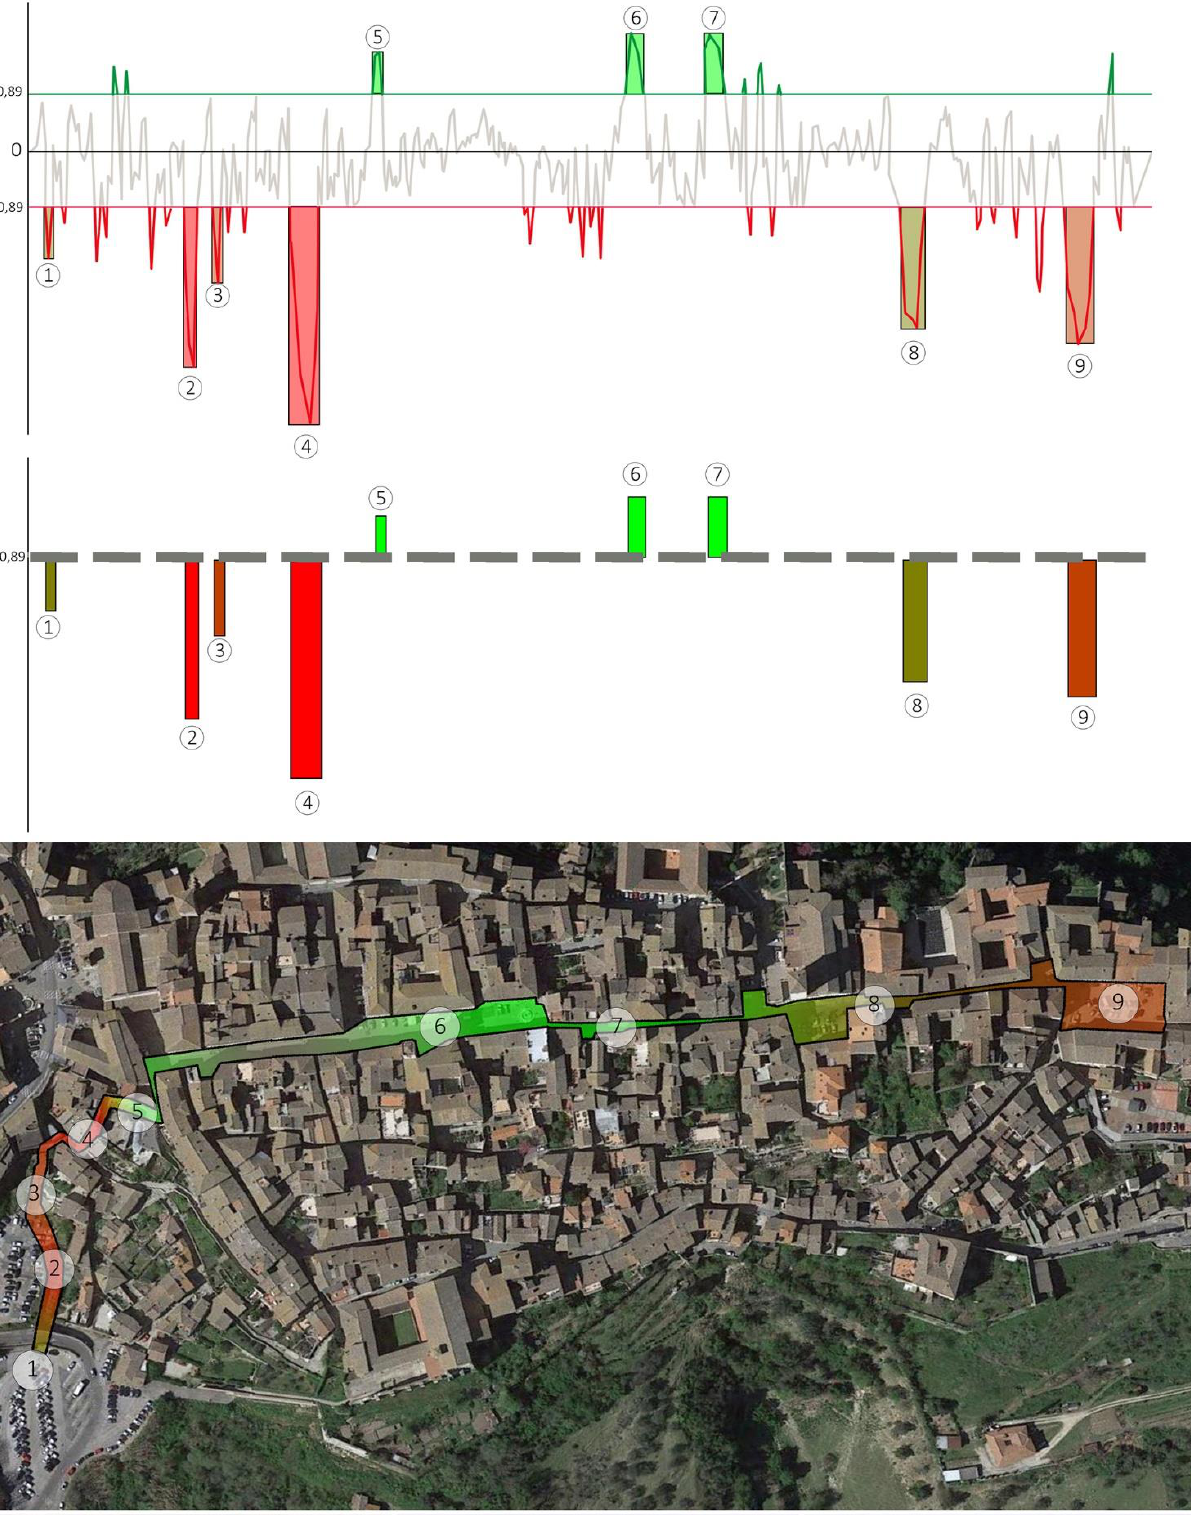
Figure 7. Valence time-dependent variation and map representation with linear